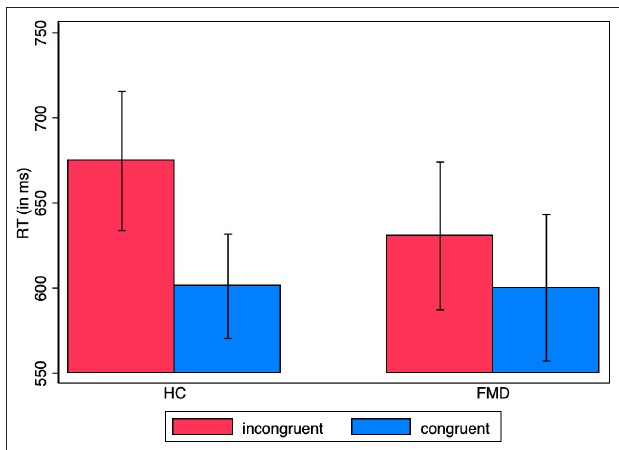
FIGURE 3 | RT in supraliminal fixed choice trials. Average reaction times by group for prime-response congruent vs. incongruent responses, for fixed choice trials only (unidirectional imperative arrows). The standard error of the mean is shown by the error bars.